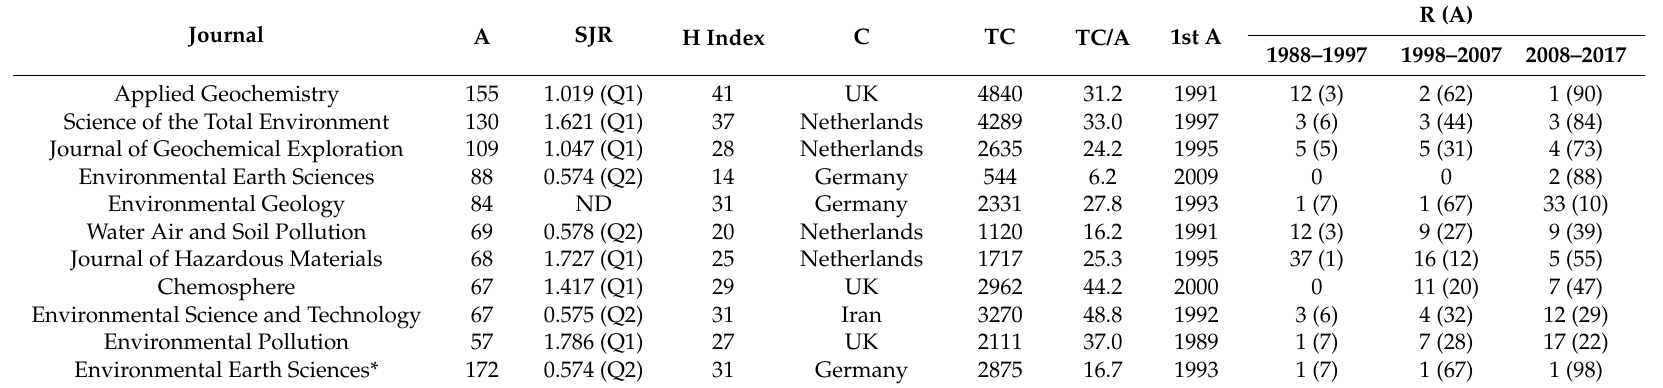
Table 2. Top 10 most productive journals for MW